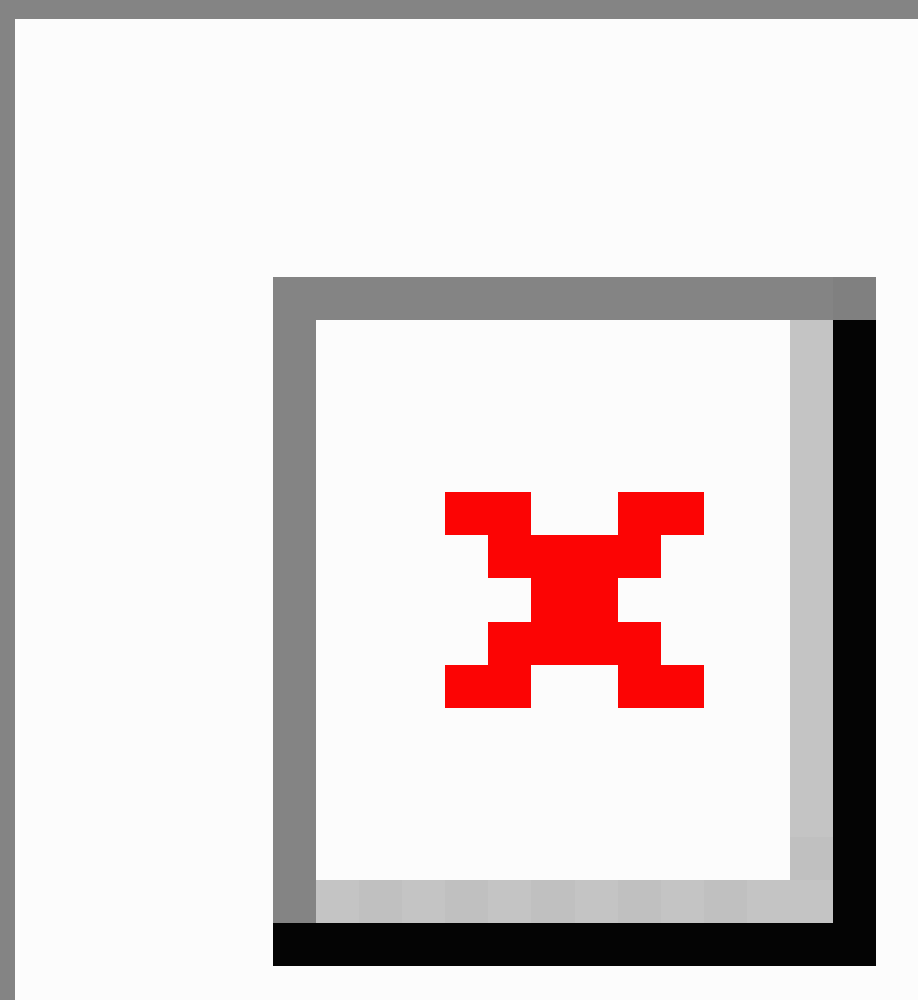
Figure 1. Development of Web-based mobile phone using online app